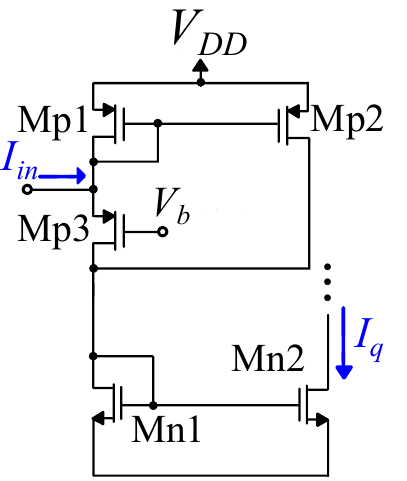
Figure 6. An example schematic of an absolute value circuit.